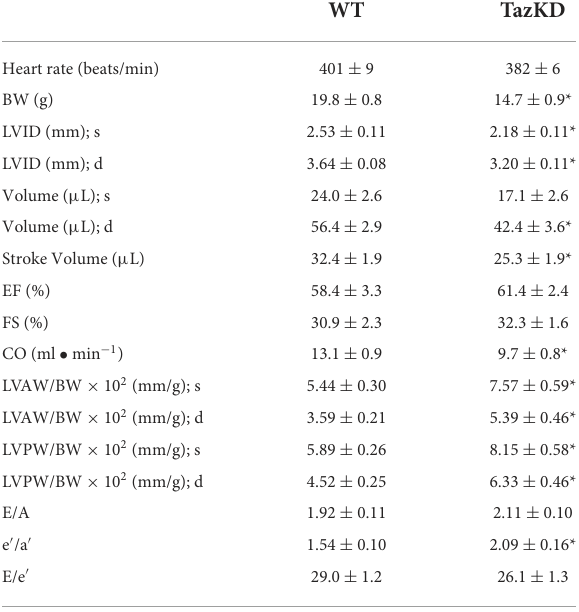
TABLE 1 In vivo baseline assessment of cardiac structural and functional parameters in WT and TazKD